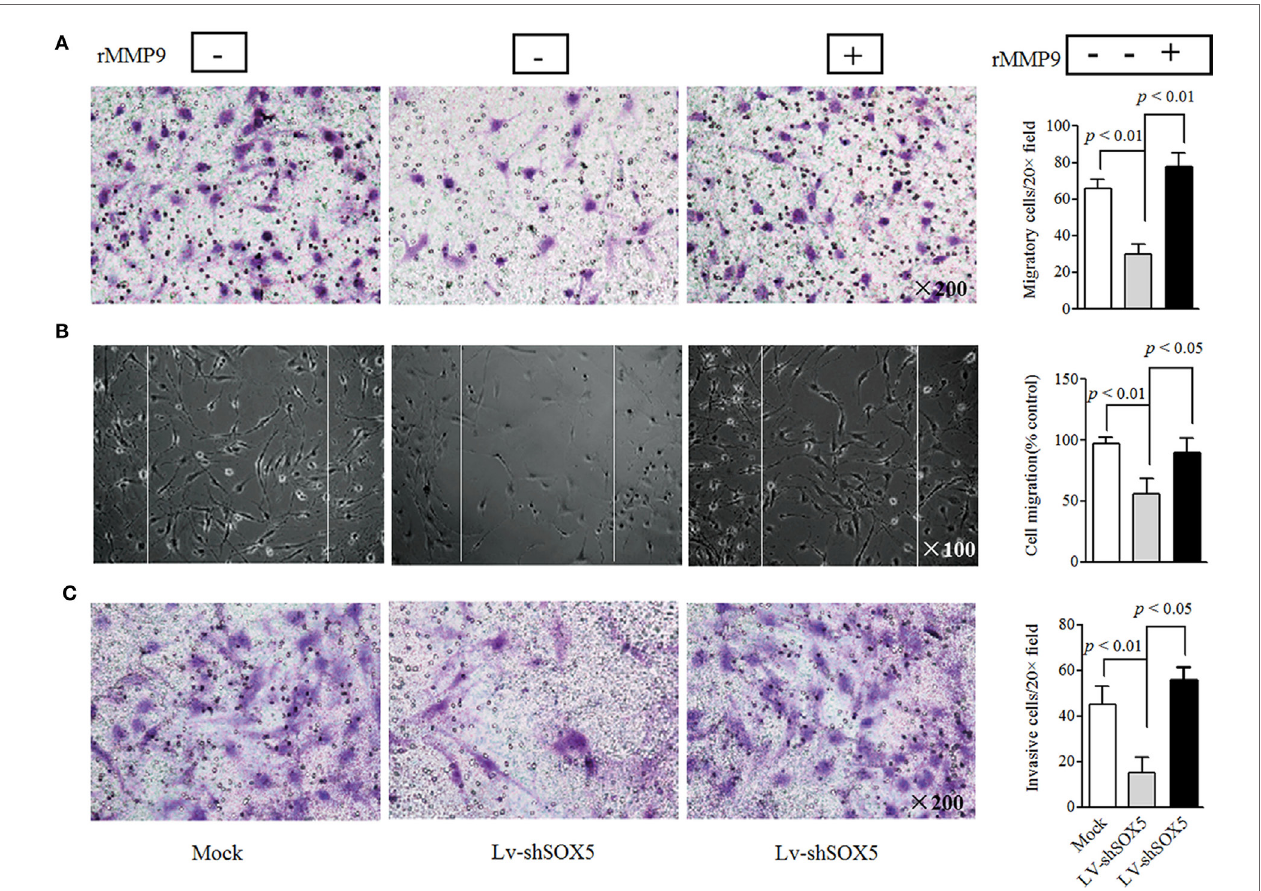
FigUre 3 | Recombinant matrix metalloproteinase (MMP)-9 rescues the inhibitory effect of SOX5 knockdown on fibroblast-like synoviocytes (FLS) migration and invasion. Following knockdown SOX5 in FLS for 96 h, FLS with or without recombinant MMP-9 (50 ng/mL) were subjected to transwell (a) , wound healing (B) , and transwell chamber invasion assay (c) after 24 h. Graphs show the quantitation data. Data are each representative of three independent